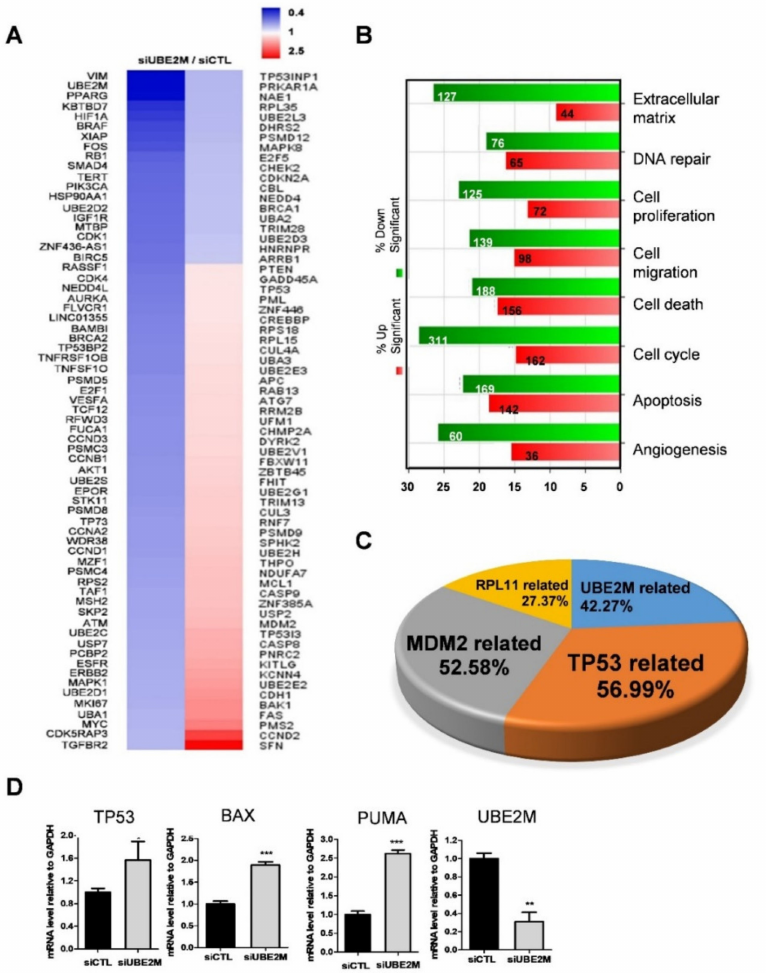
Figure 2. Differentially expressed gene profile is mainly associated with p53-related signaling and UBE2M depletion induces cell-cycle arrest and apoptosis in HCCs. ( A ) Heat map of genes enriched in UBE2M-depleted HepG2 cells. Blue and red represent increased and decreased expression of genes, respectively. ( B ) Gene ontology analysis for related signaling pathways. Green and red represent increased and decreased expression of genes, respectively. ( C ) Gene analysis for TP53-, UBE2M-, RPL11-, MDM2-related genes in a pie chart. ( D ) Effect of UBE2M depletion on TP53, Bax and PUMA in HepG2 cells by qRT-PCR. RNAs isolated from HepG2 cells transfected with control and/or UBE2M siRNA were lysed and subjected to qRT-PCR. * p < 0.05, ** < 0.01, *** p < 0.001 vs. untreated